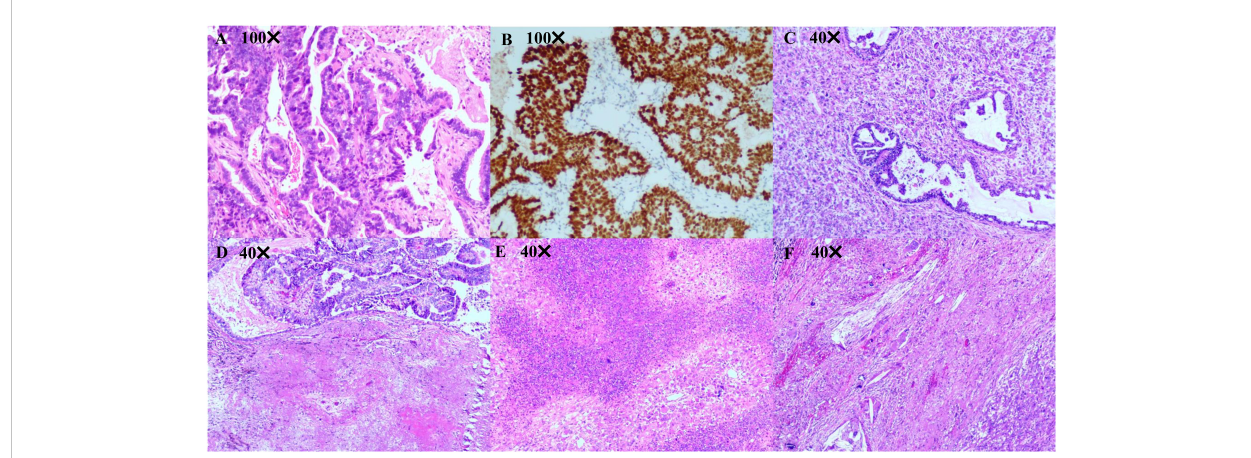
FIGURE 2 Pathological diagnosis. (A, B) Pathological diagnosis of the lung biopsy revealing a moderately differentiated lung adenocarcinoma. Immunohistochemistry results are presented as follows: TTF-1(+), Napsin A (+), CK7 (+), CK5/6 (-), P40 (-), Ki67 (50%+), Syn (-), and CgA (-). (C-F) Pathological diagnosis of lung surgery is carcinosarcoma (adenocarcinoma accounts for approximately 40% and undifferentiated pleomorphic sarcoma accounts for approximately 60%) with a size of 40 mm × 33 mm × 26 mm, and the visceral pleura appears uninvolved. No tumor involvement can be observed in the bronchial stump, with no tumor metastasis in the lymph nodes of each group ( − , 0/14). Immunohistochemistry outcomes were presented as follows: CK(pan)(partial+), Vimentin (partial+), TTF-1(partial+), CK7 (partial+), NapsinA (partial+), P40 (-), CK5/6 (-), Syn (-), CD56 (few+), S100 (-), SMA (-), Desmin (-), Calponin (-), MyoD1 (-), Myogenin (-), P53 (90%+), Ki67 (60%+), CD31 (partial +), ERG (Vascular